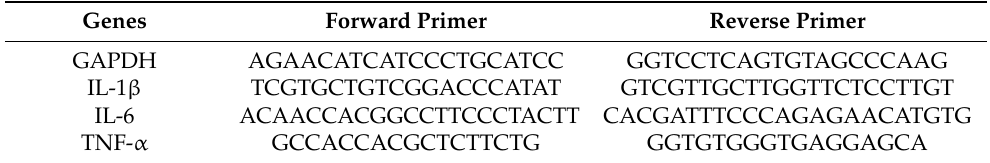
Table 3. Primer sequences of target genes for